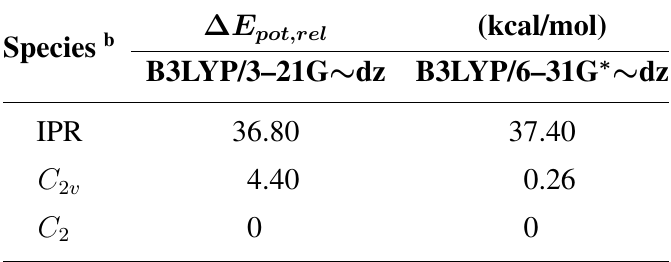
computed a in the B3LYP/3–21G (cid:24) dz pot;rel